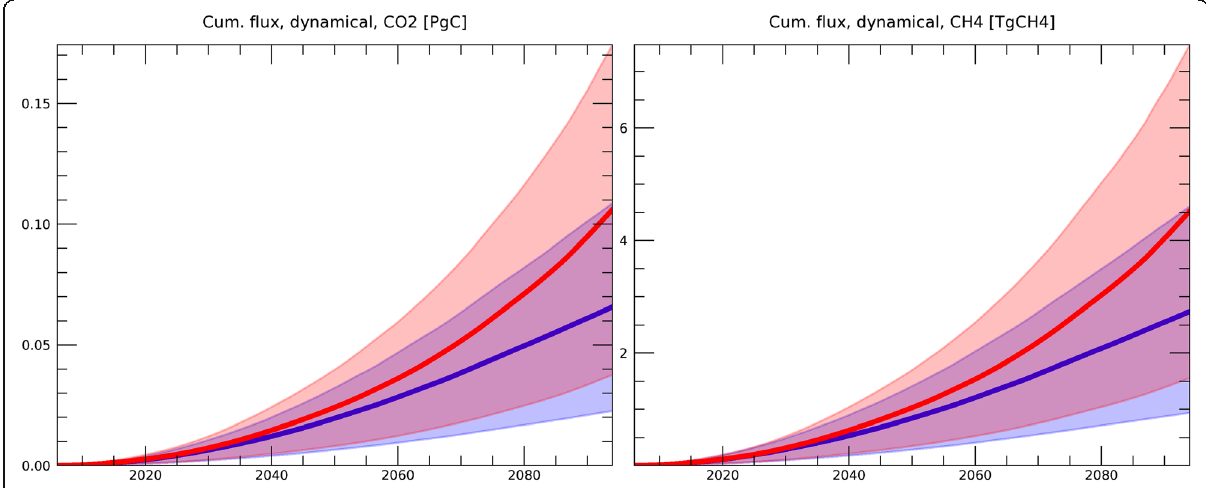
Fig. 2 Cumulative GHG flux due to dynamic degradation of the Yedoma layer for CO 2 (left, unit = PgC) and CH 4 (right, unit = TgCH4). The simulations under the RCP2.6 (blue) and RCP8.5 (red) scenarios are shown. The width of the colored area represents the 68 percentiles of the simulated results forced by five GCMs, each of which involved 300 simulations with different model parameters sampled from the uncertainty ranges shown in Table 1. The average value of the model simulations is represented by the bold blue (RCP2.6) and red (RCP8.5)